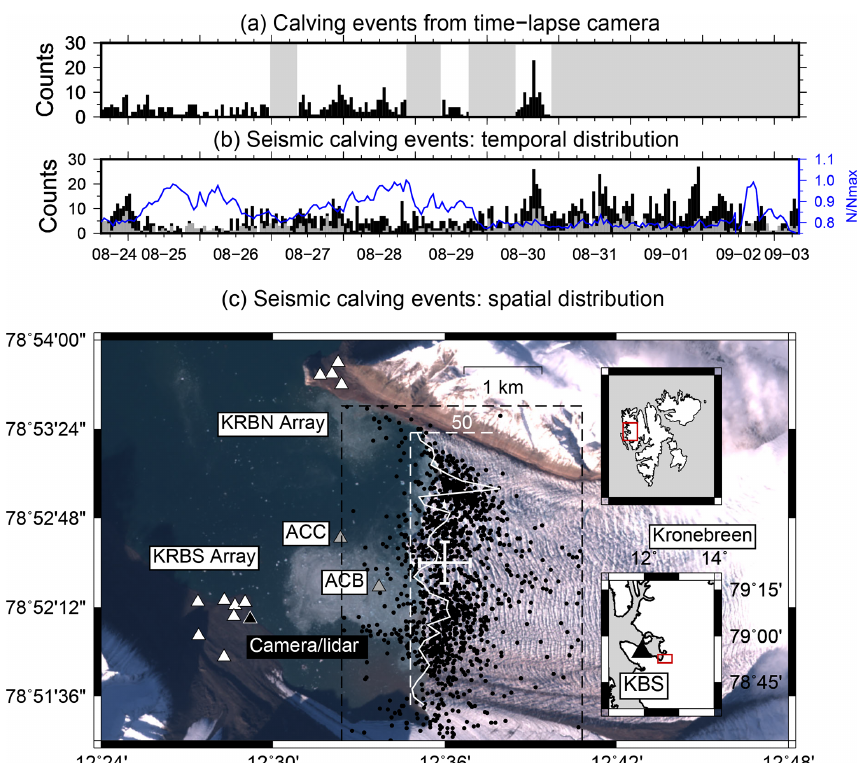
Figure 1. Calving event time series and locations. (a) Hourly counts of calving events automatically detected on time-lapse camera images. Gray areas indicate image gaps. (b) Hourly counts of seismic detections simultaneously at KRBN and KRBS (black) and at KBS (gray). Blue line shows relative variations in seismic background noise level ( N ) with respect to maximum level ( N max ) in recording period. (c) Triangles show locations of time-lapse camera (black), lidar scanner (black), seismic (white), and hydroacoustic (gray) instruments at the calving front of Kronebreen. Black points are seismic calving event locations. White error bars show an estimate of the typical location uncertainty. The white curve is the histogram of time-lapse camera event counts projected on a line (dashed) parallel to the terminus. The dashed box is used to classify located seismic signals as calving events. Insets to the right show the Arctic archipelago of Svalbard (upper) and a closeup map of the Kongsfjorden area (lower) with the location of the permanent broadband seismometer KBS in